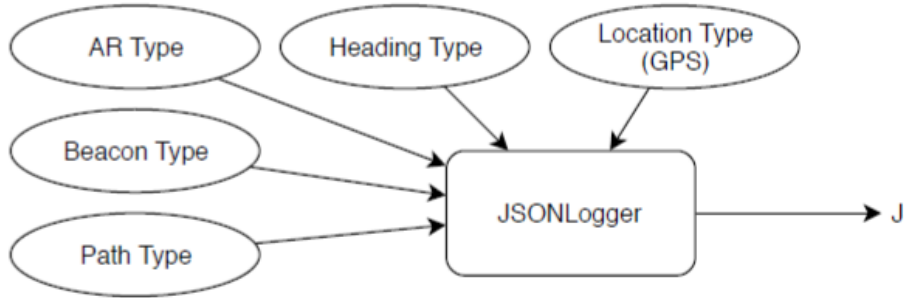
Figure 12. Overview of the JSONLogger data